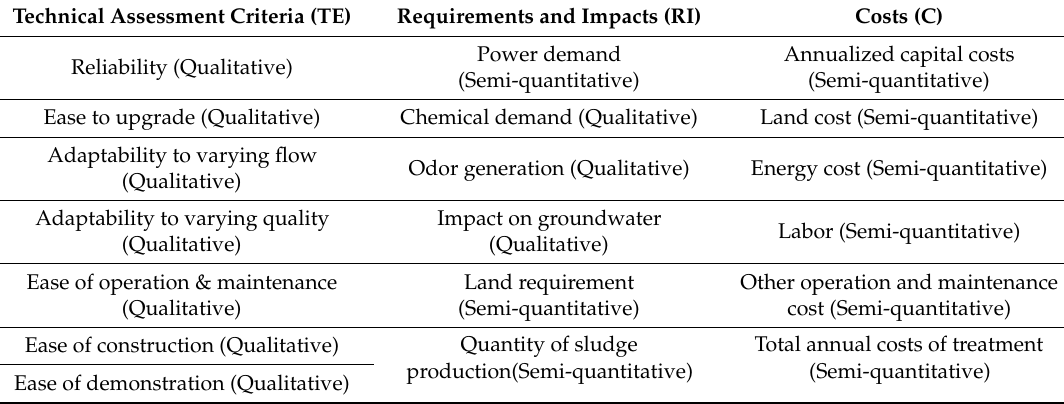
Table 9. Overview of selected assessment criteria for multi-criteria analysis with information on qualitative or semi-quantitative aspects. The values are normalized between 0 and 3: (0 = nil, 1 = low, 2 = medium, and 3 =